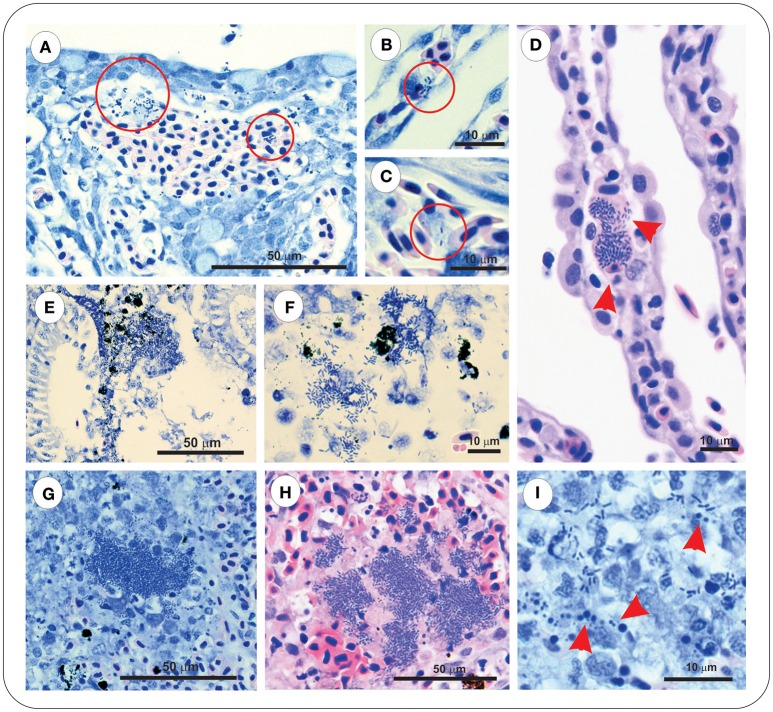
Asal were observed in gill, kidney and spleen of infected PBS-injected controls at 8 dpi. Gill stained with Wright's Giemsa (A–C) or Haematoxylin & Eosin (D), showing epithelial hyperplasia and fusion of secondary lamellae with local hemorrhage and disseminated bacteria (red circles). Bacteria were also observed within vessels of intact secondary lamellae (B), as well as appearing within large lymphoid cells (C,D, red arrowheads). Kidney of Asal-infected PBS-injected controls was characterized by areas of degradative necrosis and hemorrhage associated with bacterial colonies (E,F). Bacterial colonies were also observed in Asal-infected spleen (G,H), with areas of pyknotic nuclei associated with bacterial cells (I, red arrowheads).